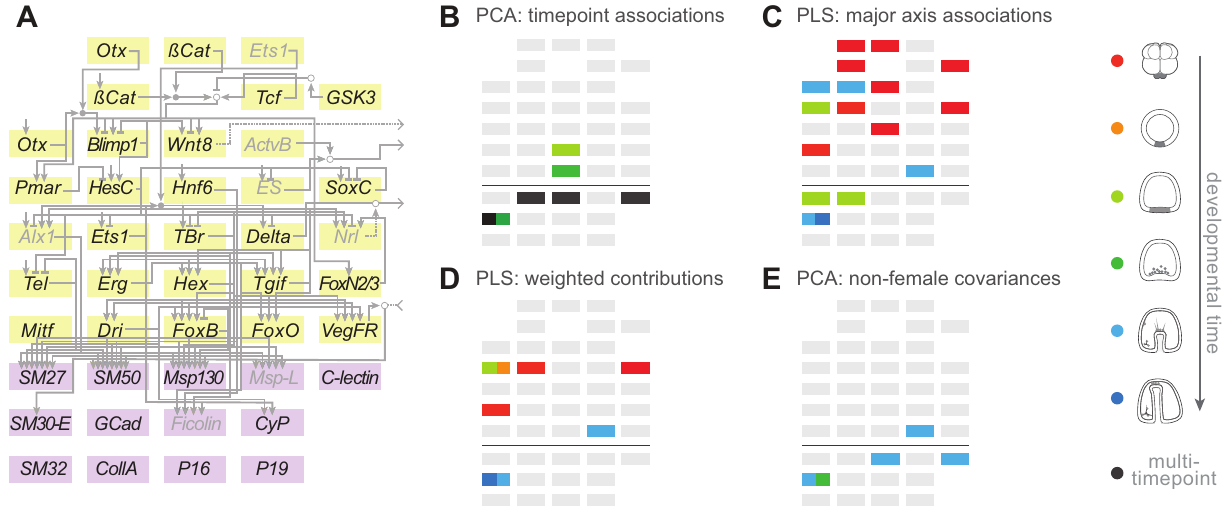
Figure 6. Correlations between gene expression and larval morphology. (A) Gene regulatory sub-network in skeletogenic cells (see Figure 1 for broader network context). Yellow boxes indicate genes encoding regulatory proteins; purple boxes indicate genes encoding structural proteins of the skeleton and surrounding matrix. These boxes correspond to rectangles in the remaining panels, with a horizontal line separating the two classes of genes. (B–E) Results of tests for correlations between variation in gene expression and variation in skeletal morphology. Gray indicates no correlation; color indicates correlation with expression from a single time point; black indicates a correlation based on multiple time points (see Text S1). (B) Morphological associations with expression based on PCA. SM30-E is related to PC I (primarily length), FoxB and Hex with PC III (primarily aspect ratio). (C) Morphological associations based on partial least squares analysis. Very early effects (time point 1) operate through regulators high in the network. (D) Morphological associations based on weighted contributions by partial least squares analysis. Four genes show associations from early stages and three from late stages. (E) Morphological associations that are conservatively based solely on male genetic contributions. The three strongest associations come from late expression. Note that SM30-E is identified in all four